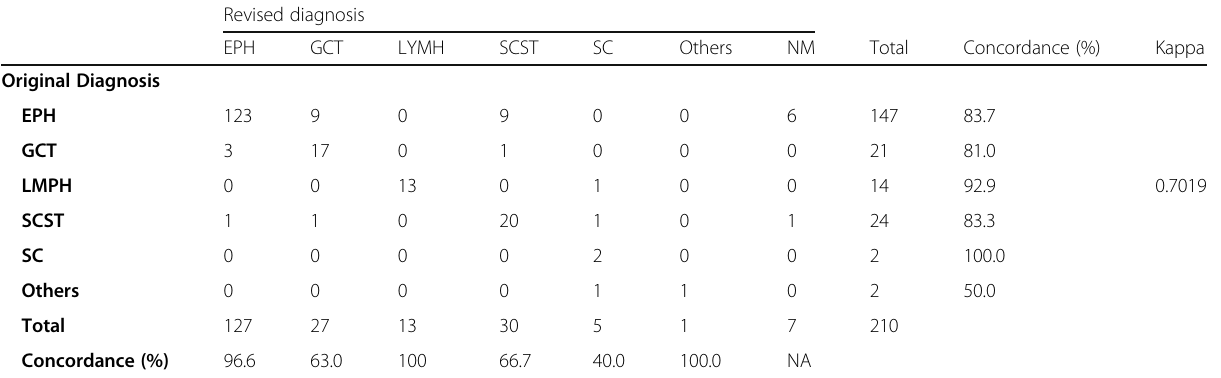
Table 1 Original diagnosis and IHC integrated revised ovarian cancer